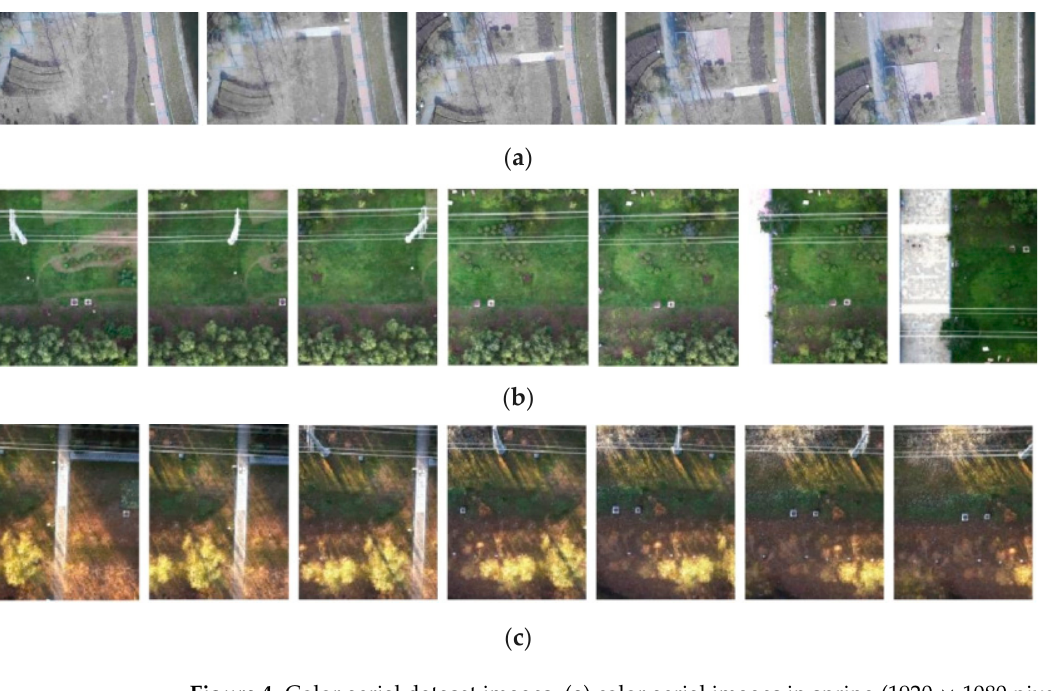
Figure 4. Color aerial dataset images. ( a ) color aerial images in spring (1920 × 1080 pixels); ( b ) color aerial images in summer (1472 × 1852 pixels); ( c ) color aerial images in autumn (1472 × 1852 pixels).